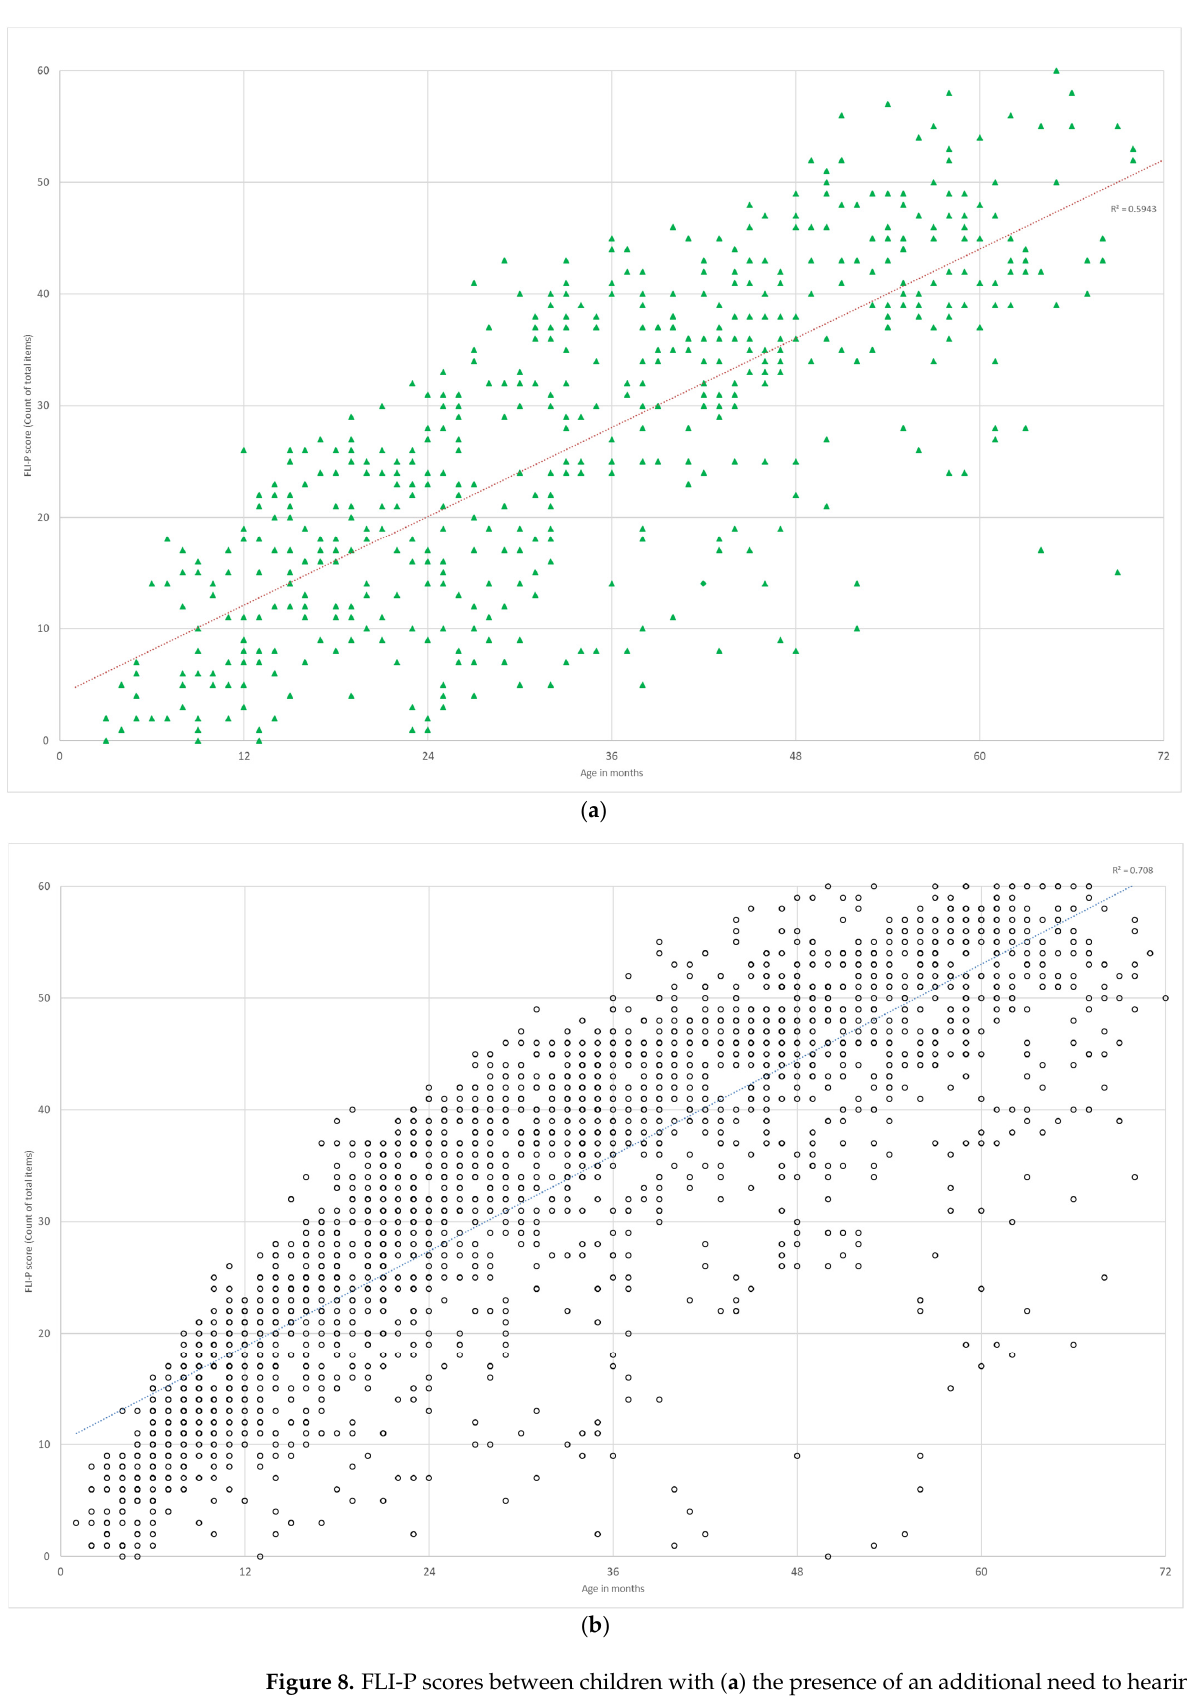
Figure 8. FLI-P scores between children with ( a ) the presence of an additional need to hearing loss and ( b ) no additional